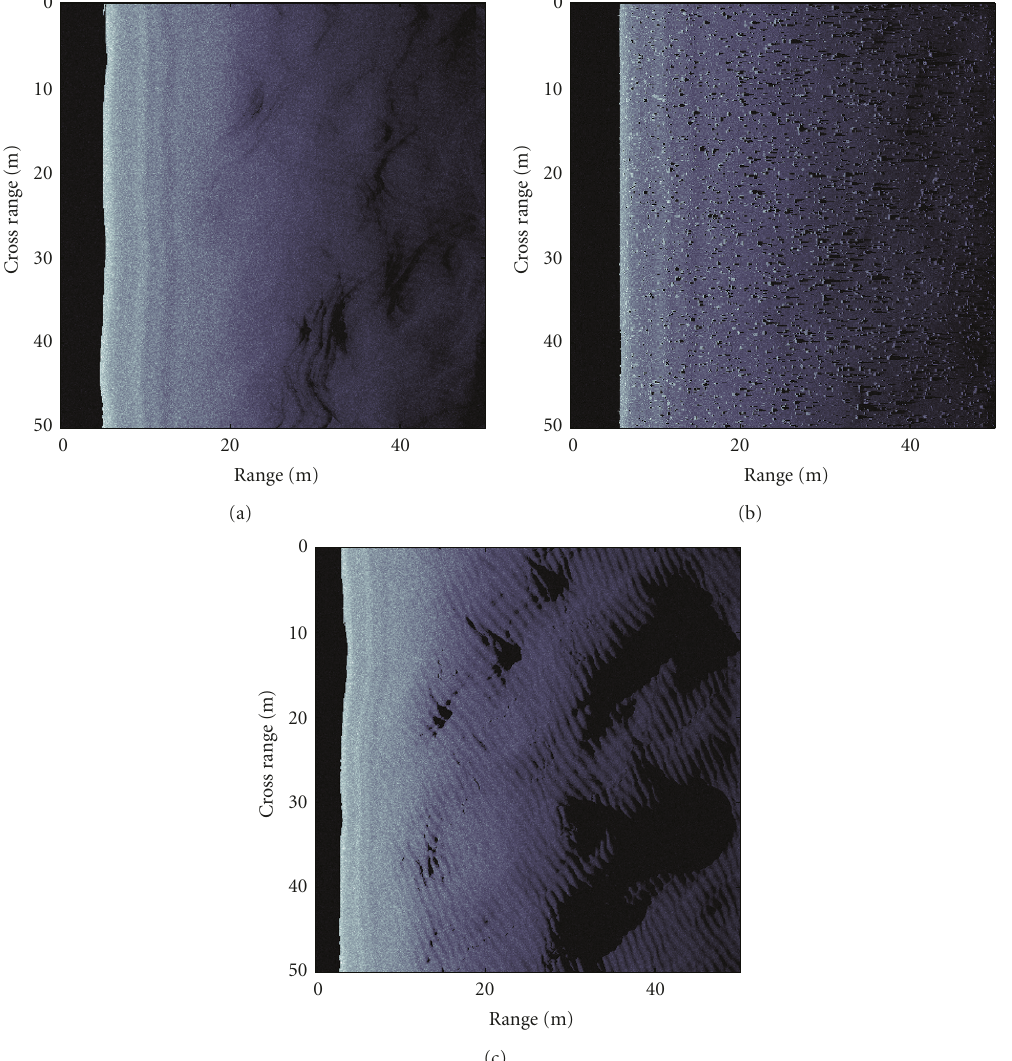
Figure 8: Examples of simulated sonar images for di ff erent seabed types (clutter, flat, ripples), 3D elevation and scattering strength. (a) represents a smooth seabed with some small variations, (b) represents a mixture of flat and cluttered seabed and (c) represents a rippled